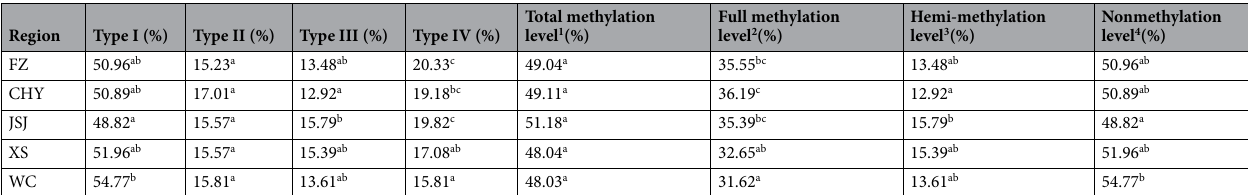
Table 2. Analysis of DNA methylation levels in different regions of rice. a–c different lowercase letters represent significant different among the five regions, p < 0.05; 1. Total methylation level: (Type II + Type